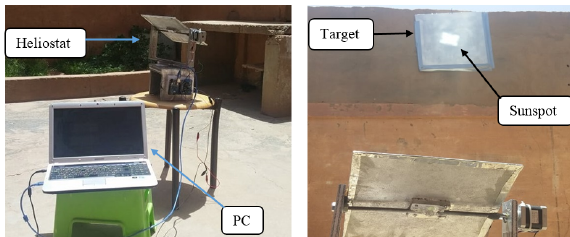
Fig. 9. Prototype carried out on the test site